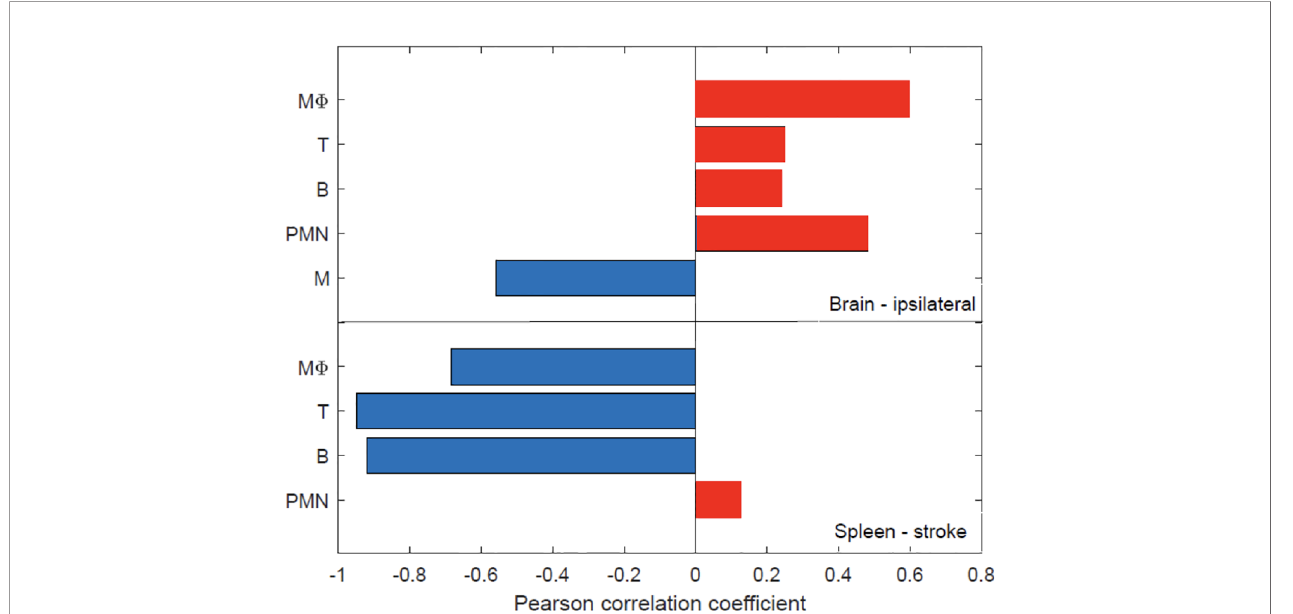
FIGURE 9 | The relationship between the number of immune cells present in the brain and spleen and stroke outcome as determined via the neurological de fi cit score (NOS). A Pearson correlation coef fi cient was computed among the NDS score and the number of cells in the brain and spleen after stroke - the red and blue colors denote positive and negative correlation, respectively. The number of cells were recorded directly after MCAO (i.e. 0 hours) as well as at 24, 48, 72, 96, 120 hours post-MCAO. Similarly, the NDS was measured at perfusion (i.e. 0 hours) and 24, 48, 72, 96, 120 hours following perfusion. N=14 mice were used, but recordings of each cell type at every time point was not possible across all animals Supplementary Table 1 for the number of various cell type measurements that were attained at each time